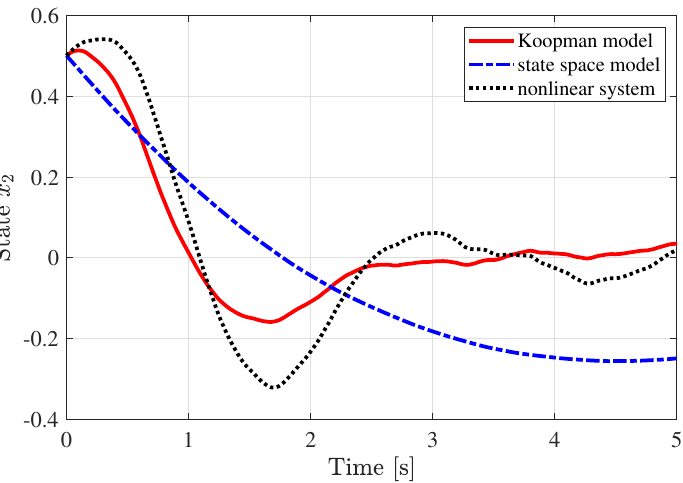
Figure 6. State x 2 of the Koopman model, the linear state-space model, and the plant system. At Stage 2, based on flipped input–output data { y ( k ) , u ( k ) } , we design filter Q such that any desired L 2 gain specification is satisfied. In the same manner as the plant